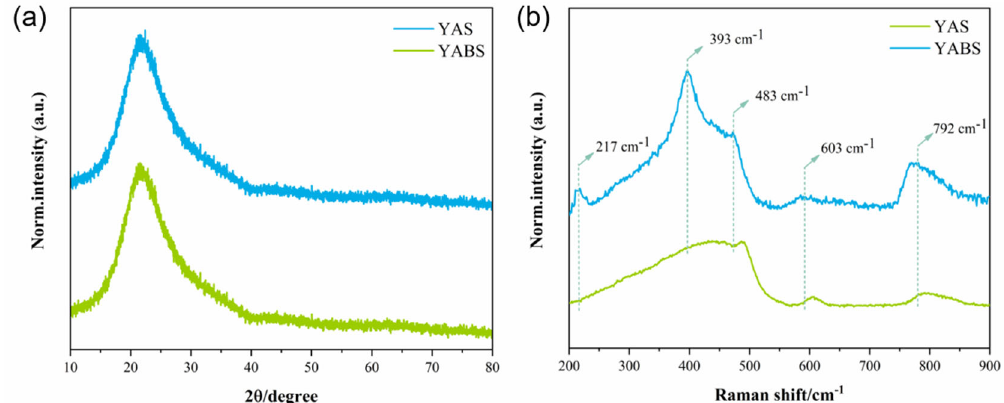
Figure 3. ( a ) XRD patterns and ( b ) Raman spectra of YABS and YAS glass. Table 2. Structural vibrations in Raman spectra of silica glass and YAG crystals.